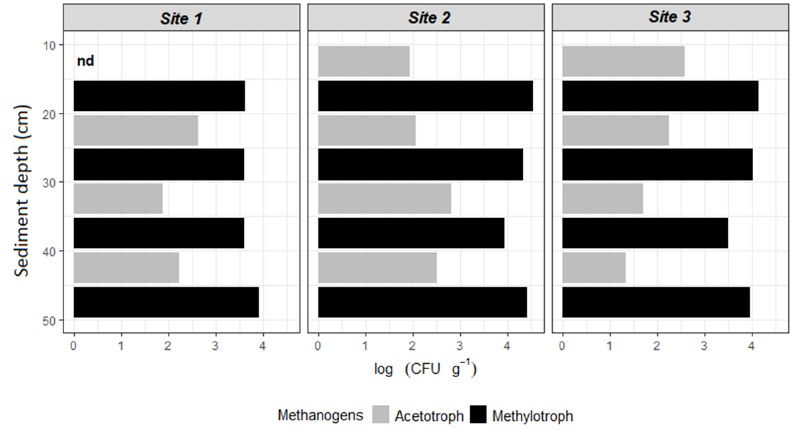
Figure 3. The abundance of methylotrophic and acetotrophic methanogens via the spread plate count method. The number of panels represents the three sampling sites. Data were only collected in the dry season. The values are the average of two replicates. “nd” means “not detected”.